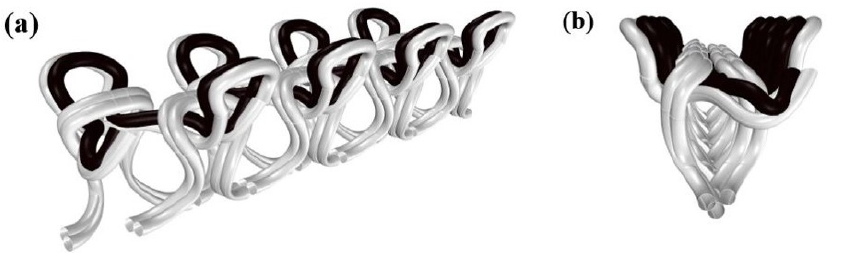
Figure 14. ( a ) The illustration of the knitted sample which conductive yarn inserted inside and elastic yarn positioned outside (CI), ( b ) Representation of the unfolded loops in a course which shows the relative position of the conductive (black line) and elastic (grey line)